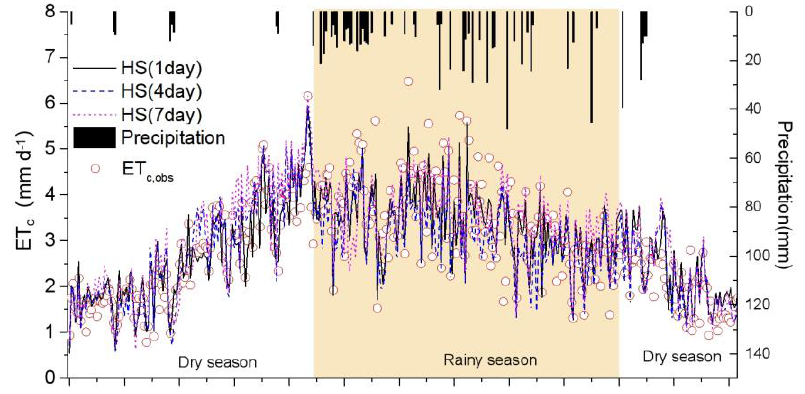
Figure 8. ET c,for for 1−, 4−, and 7− -day forecasts and daily observed ET c values.